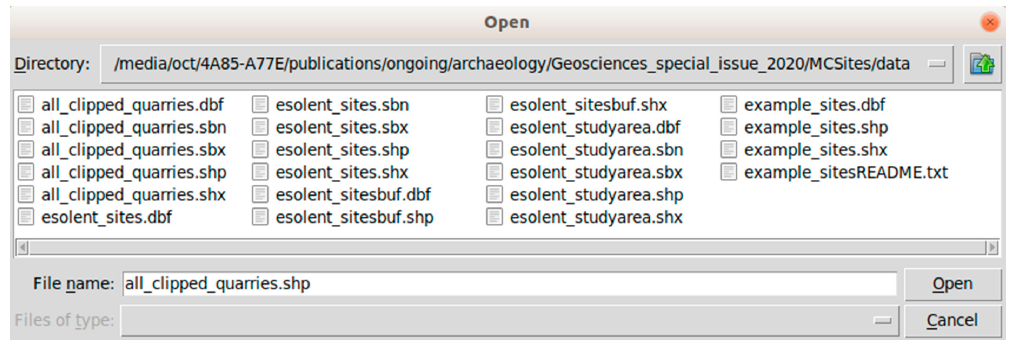
Figure A1. “Open” dialog, with shape file selected.